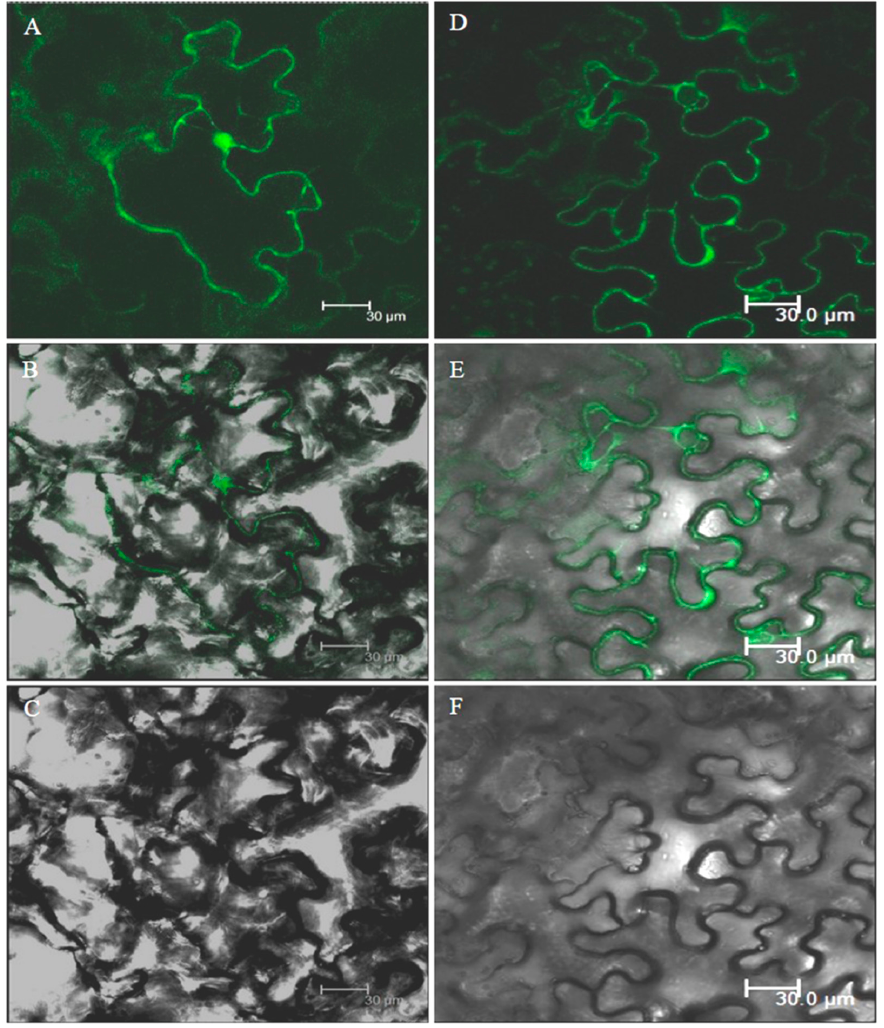
Figure 18. Subcellular localization of GFP-AnnAt8 by transient expression in tobacco leaf epidermal cells. ( A – C ) Subcellular localization of GFP control; ( D – F ) Subcellular localization of GFP-tagged